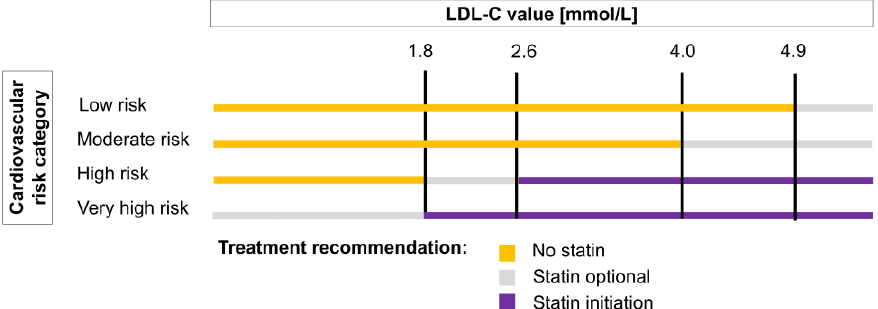
Figure 2. Statin treatment recommendations based on cardiovascular risk category and low-density lipoprotein cholesterol levels according to the 2016 European Society of Cardiology/European Atherosclerosis Society Guidelines for the Management of Dyslipidemias.